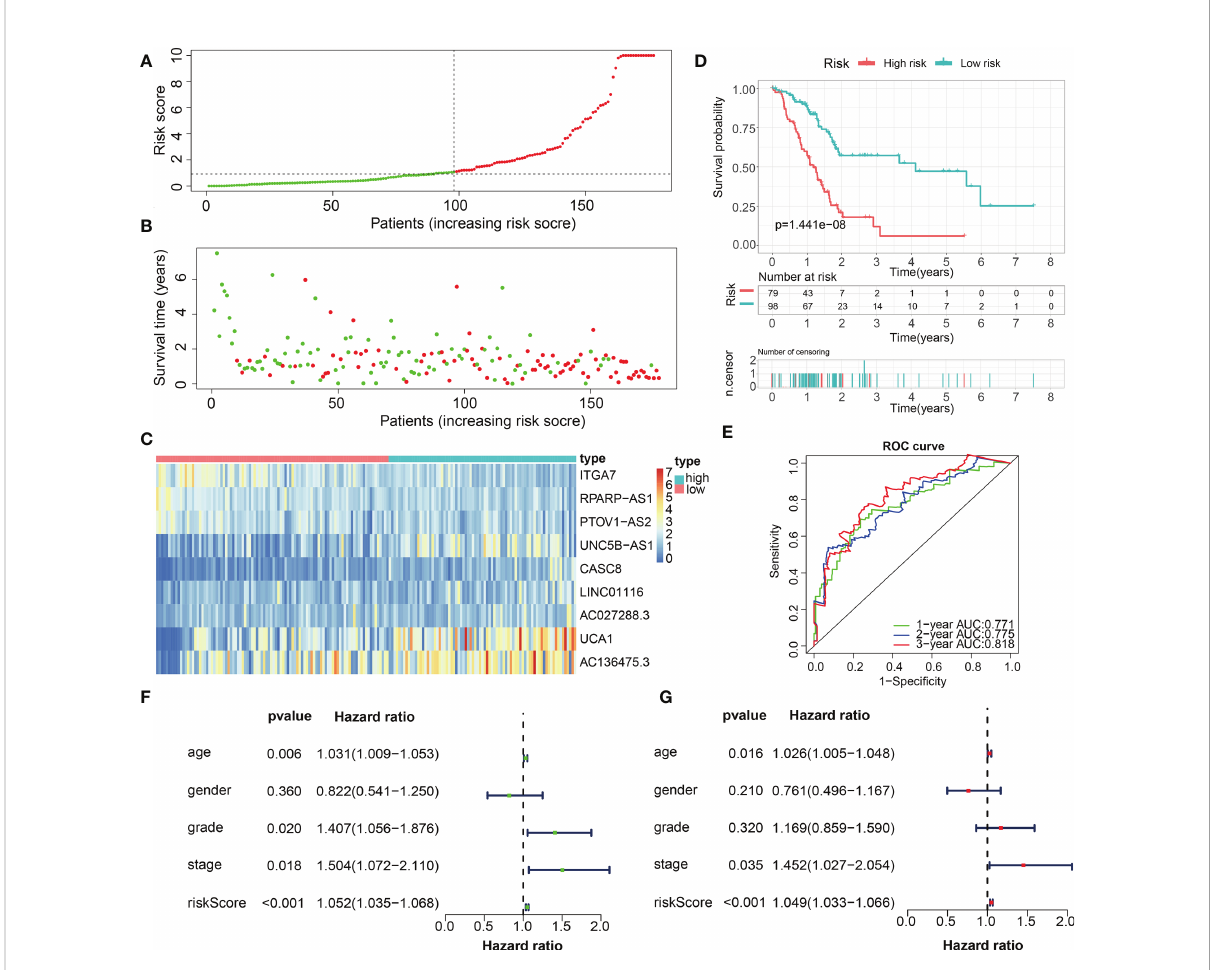
FIGURE 10 Internal validation of the robust ECM-APP in the test2 cohort. (A) Sectionalization premised on the median risk score. (B) Survival status and risk score distributions. (C) Heatmap illustrated the expression pro fi les of 9 genes integrated into the prognostic signature. (D) Survival curve of OS time in low-risk and high-risk subgroups. (E) ROC curve of 1-, 2-, and 3-years of in test2 cohort, area under the curve (AUC) of the curve are 0.771, 0.775, and 0.818, correspondingly. (F) Univariate cox regression analysis showed the independence of risk score, stage, grade, gender, and age. (G) Multivariate cox regression analysis showed the independence of risk score, stage, grade, gender, and